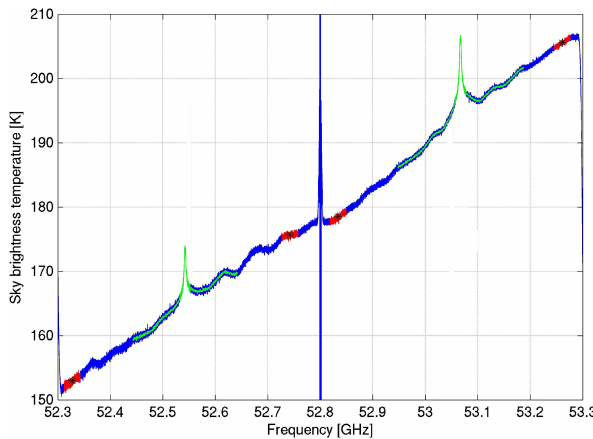
Figure 10. Example of calibrated spectrum of the FFT spectrom- eter. The frequency ranges marked in red are the areas used for the correction of tropospheric attenuation. The mean value of each range, indicated by a black star, is the value used for the